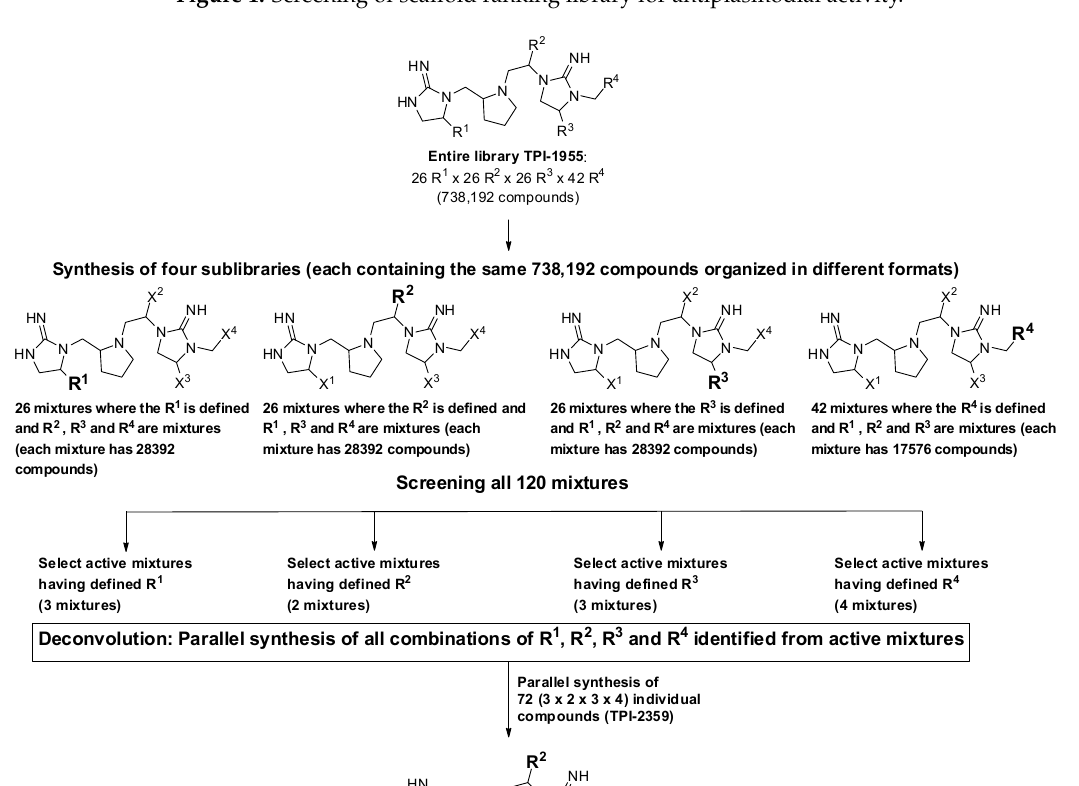
Figure 1. Screening of scaffold ranking library for antiplasmodial activity.